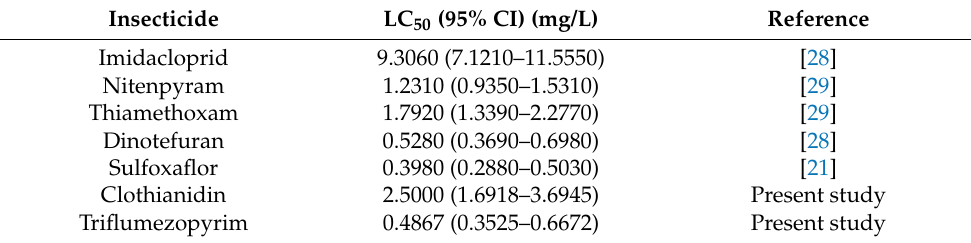
Table 2. LC 50 values of the susceptibility baseline of L. striatellus